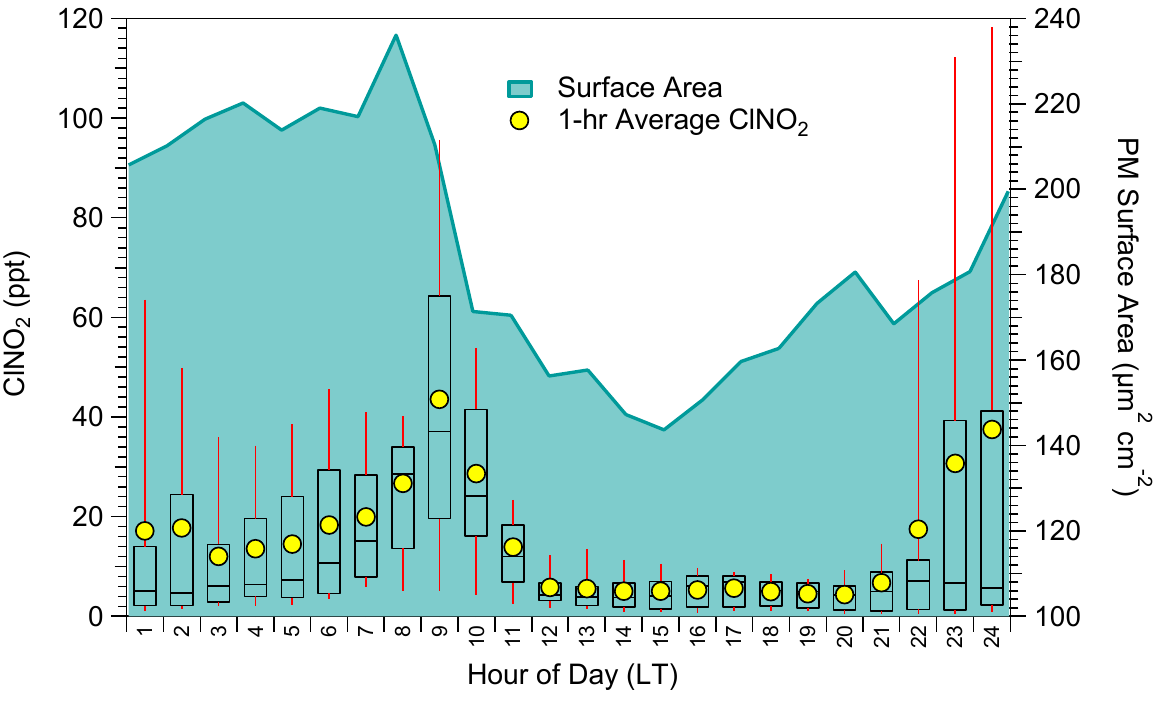
Figure 4. Diurnal cycle of ClNO 2 concentrations, showing two distinct patterns that are present during the campaign: (1) an early morning peak concentrations where ClNO 2 is advected to the site, and (2) late night peak concentrations, when ClNO 2 and N 2 O 5 concentrations correlate significantly, suggesting more local inland production of ClNO 2